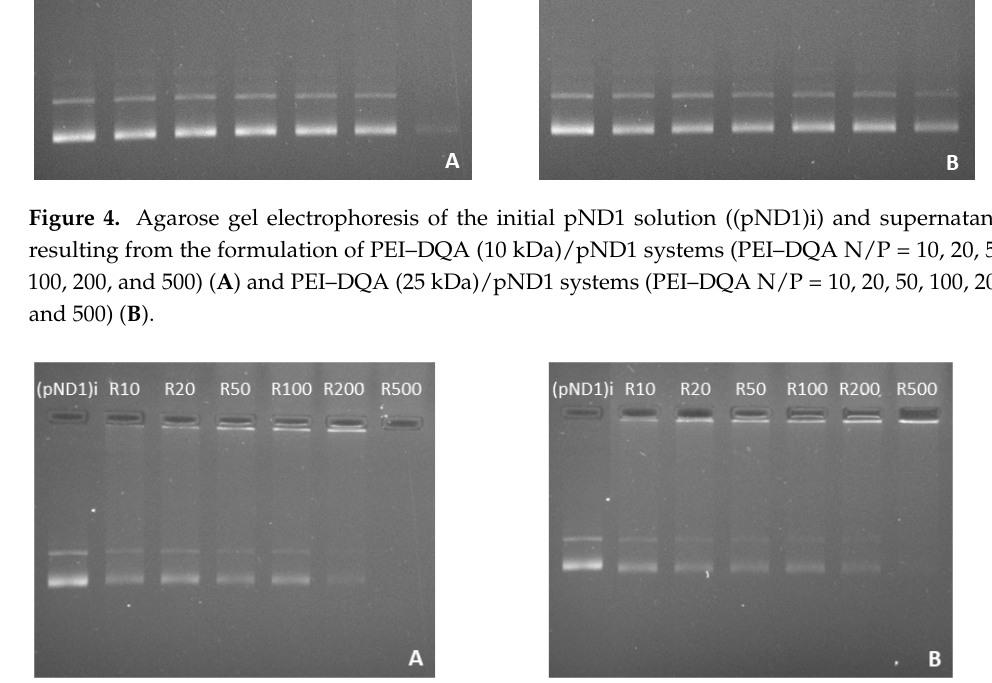
Figure 6. Agarose gel electrophoresis of the initial pND1 solution ((pND1)i) and supernatants re- sulting from the formulation of PEI–DQA (10 kDa)/TAT/pND1 systems (PEI–DQA N/P = 10, 20, 50, 100, 200, and 500, and TAT N/P = 2) ( A ) and PEI–DQA (25 kDa)/TAT/pND1 systems (PEI–DQA N/P = 10, 20, 50, 100, 200, and 500, and TAT N/P = 2) ( B ).